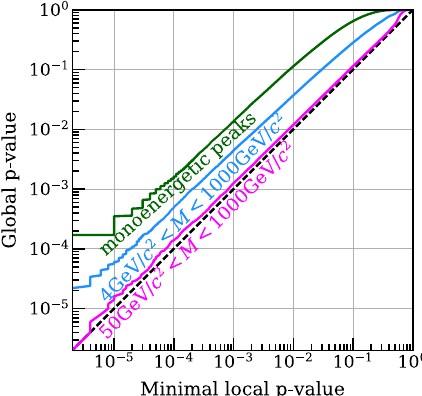
Fig. 1 Illustration of the look elsewhere effect (LEE) for a search for dark matter with three families of dark matter models in a simplified model. Global p values are plotted as a function of local p value for a simplified LXe-TPC model computed with the procedure of Refs. [21, 22]. A search for spin-independent recoils with WIMP masses between 50 GeV / c 2 and 1000 GeV / c 2 shows a negligible trial effect, as the spectra are almost degenerate. A search for spin-independent WIMPs with masses from 4 GeV / c 2 to 1000 GeV / c 2 , representing a typical LXe-TPC mass range is shown in blue. The green line shows the trial factor for a search for 29 monoenergetic nuclear recoil peaks between 1 keV and 30